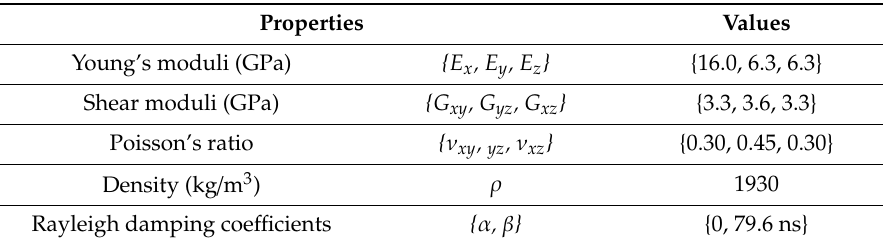
Table 1. Cortical bone properties